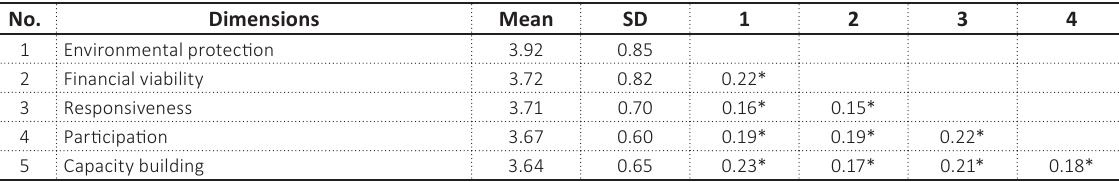
Table 2. Descriptive statistics of respondents’ assessment of the level of five challenges facing local governments and correlation ( N = 251)